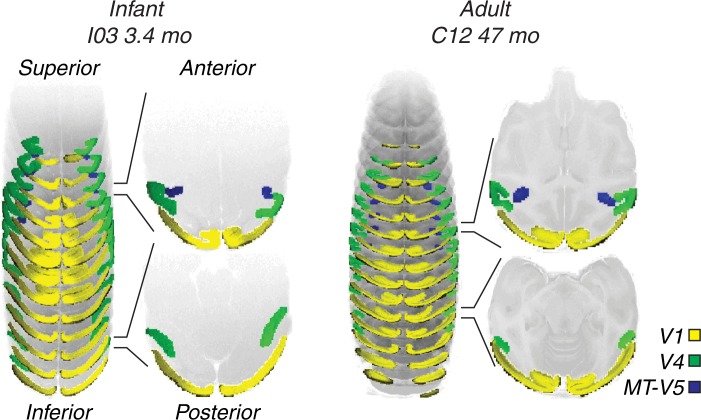
Example of volume selection.Left is infant I03 at 3.4 months of age; right is adult C12. The three target brain areas are color-coded (V1: yellow, MT-V5: blue and V4: green). Brain areas typically span multiple slices. Right of the stacked slices are two example slices with cross-sections.